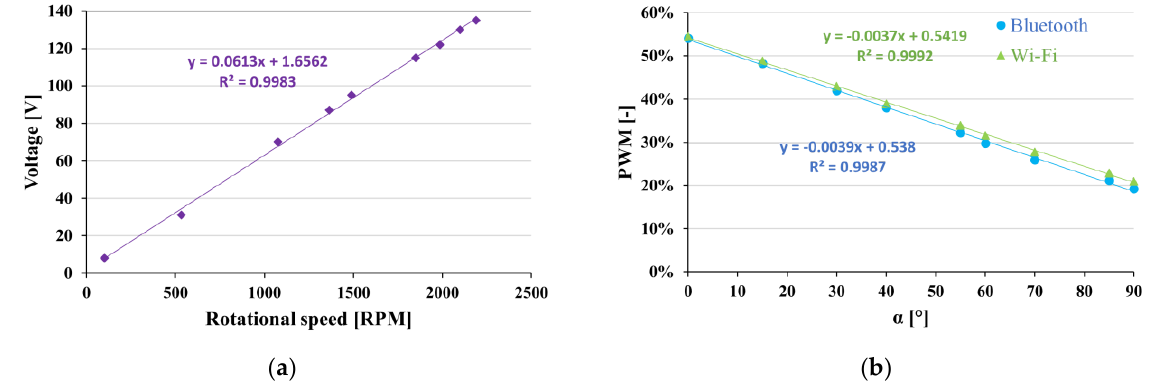
Figure 9. The dependence of the engine supply voltage on the rotational speed.